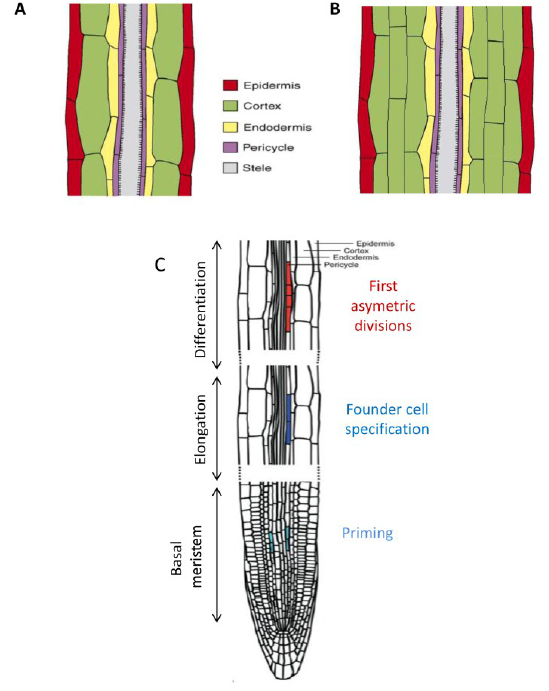
Figure 1. Schematic organization of the primary root. ( A ) The different cell layers in a longitudinal section along the primary root in Arabidopsis, note that there is only one cell per root cell layer; ( B ) the different cell layers in a longitudinal section along the primary root of M. truncatula , showing several cortical cells (only three are represented whereas four to five layers are usually observed); ( C ) Longitudinal organization of the primary root in the younger region of the root (close to the root tip), showing the different zones of the LR specification steps. ( A ) and ( B ) are adapted from [50]; ( C ) is adapted from